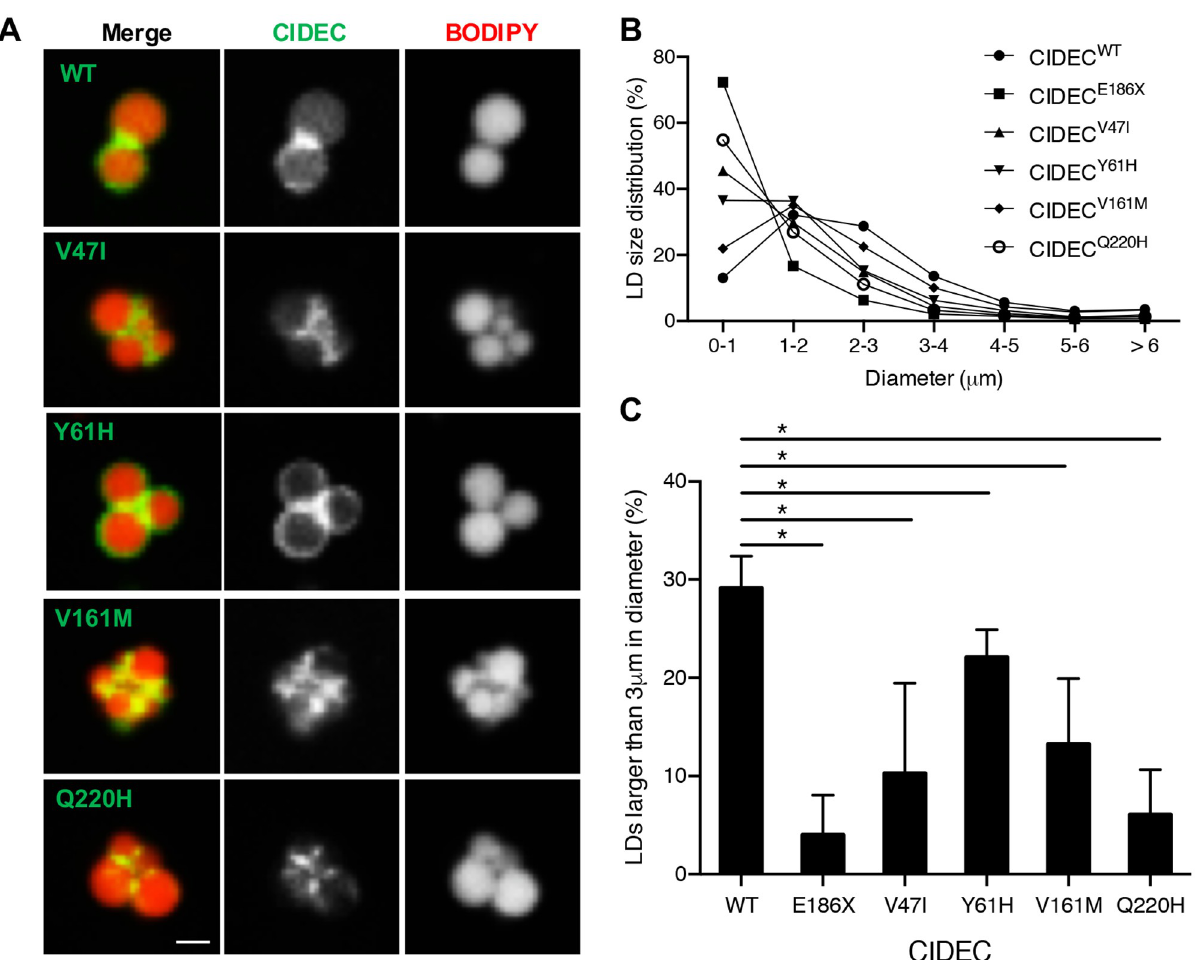
Fig 3. AMD CIDEC variants localize to lipid droplets (LDs) but cause a defect in LD enlargement. (A) Representative images of GFP-tagged CIDEC wild-type (WT) or rare variants localized to LDs labeled in red by BODIPY 558/568. Scale bar: 2 μ m. (B) Size distribution of LDs in pre- adipocytes expressing CIDEC WT or each of the rare variants (diameters in μ m). (C) Percentage of LDs with a diameter larger than 3 μ m. N = 3 (mean ± SD, Student’s t test, * p < 0.05).